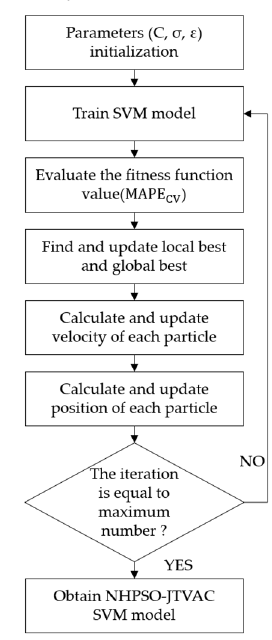
Figure 2. Flow chart of SVM based on NHPSO-JTVAC.